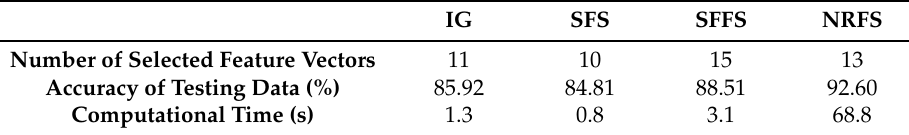
Table 6. Experimental results of noisy data set of EEG signals.